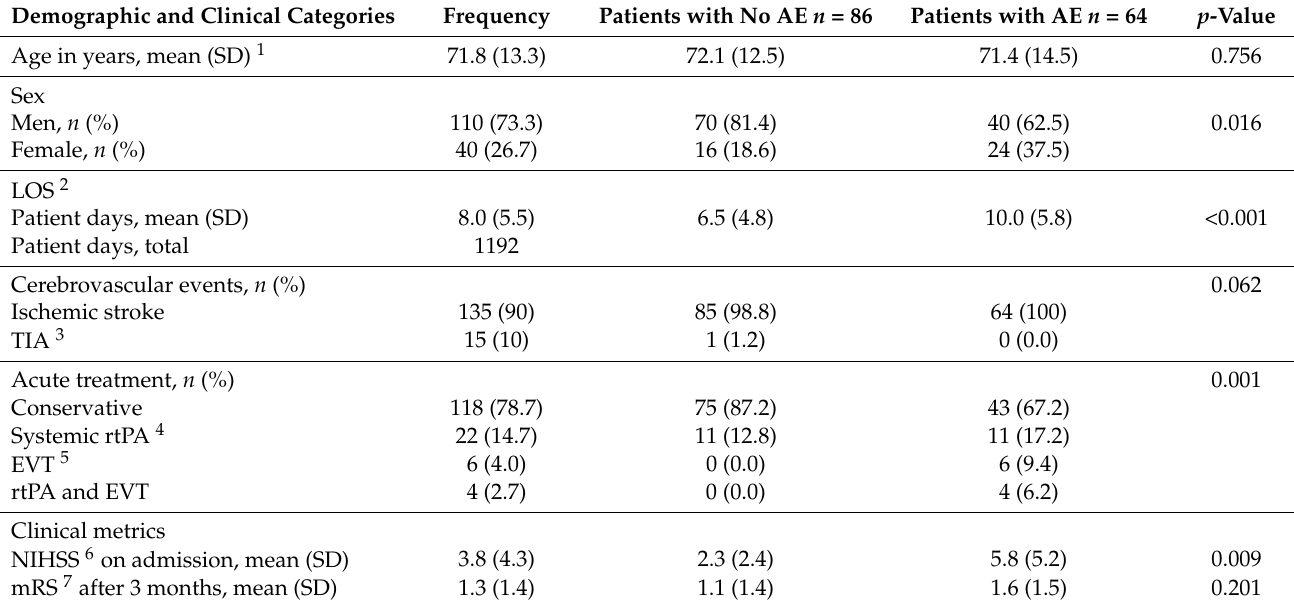
Table 1. Demographics and clinical characteristics.